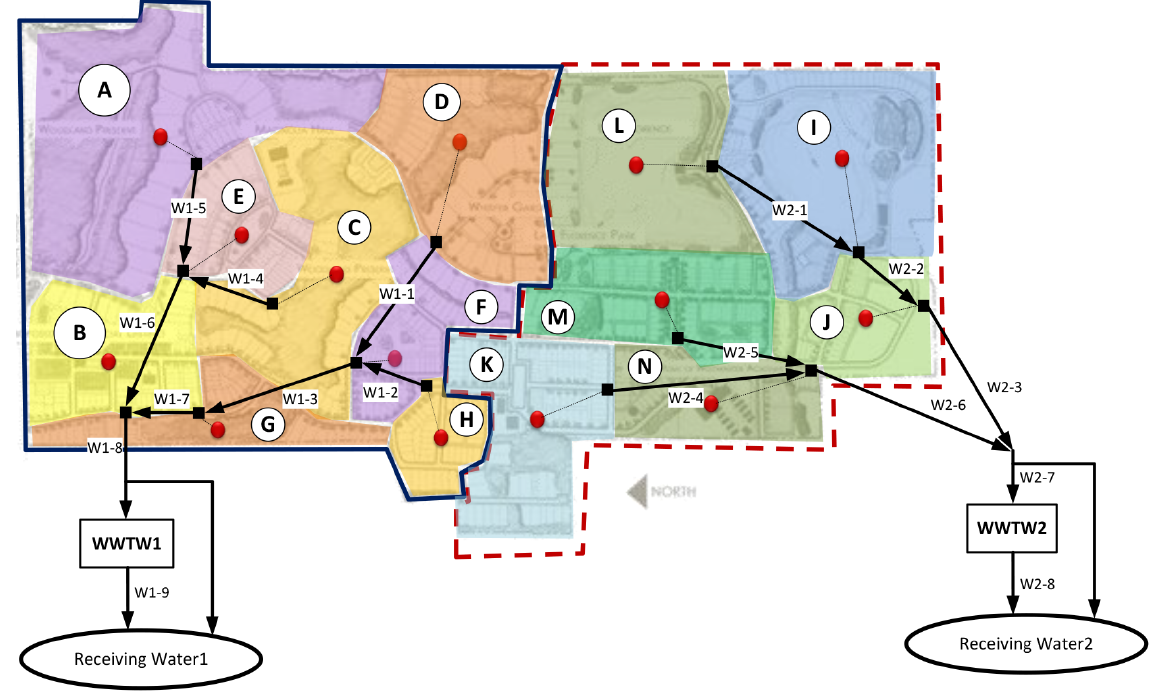
Figure 2. A schematic example of a sewer system representation in WaterMet 2 ; W1- & W2-=sewer system 1 and 2 respectively; WWTW=wastewater treatment